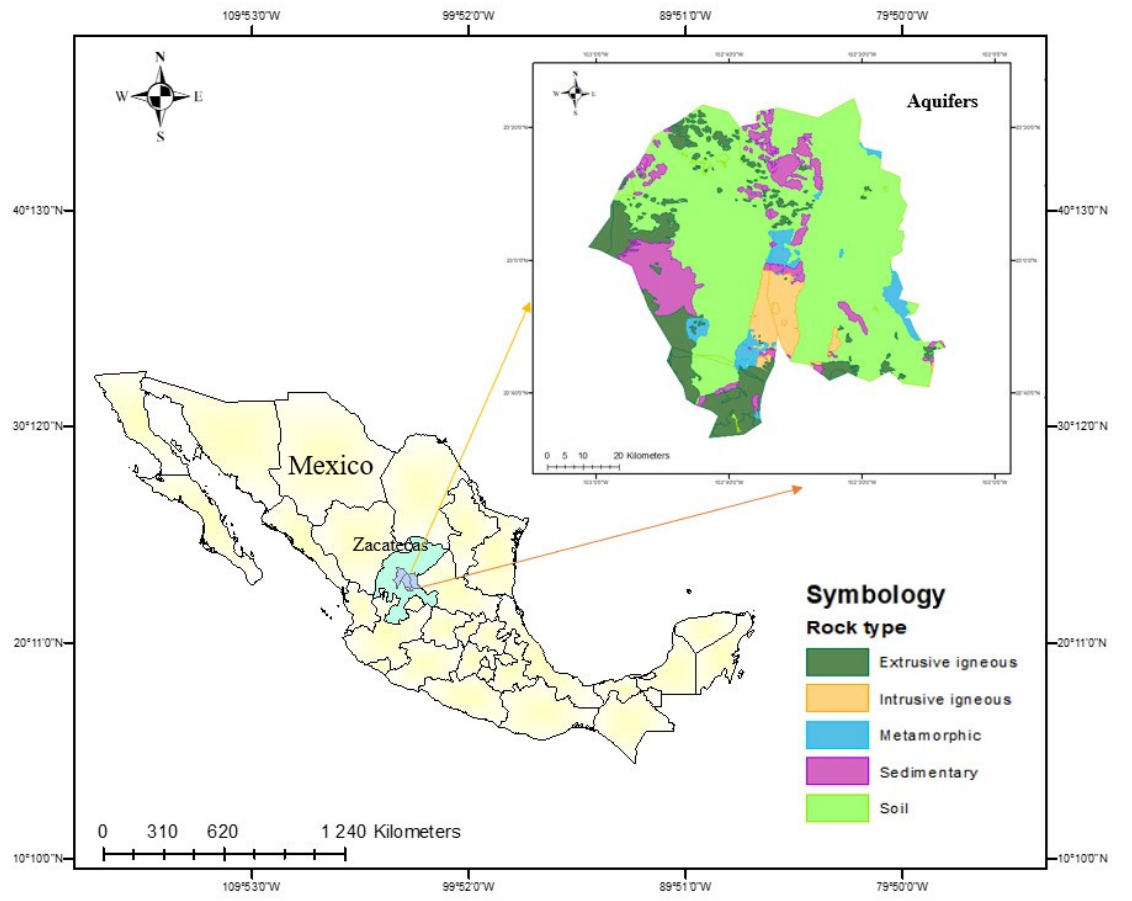
Figure 1. Study area: State of Zacatecas, Mexico, and the corresponding geology of the aquifers.